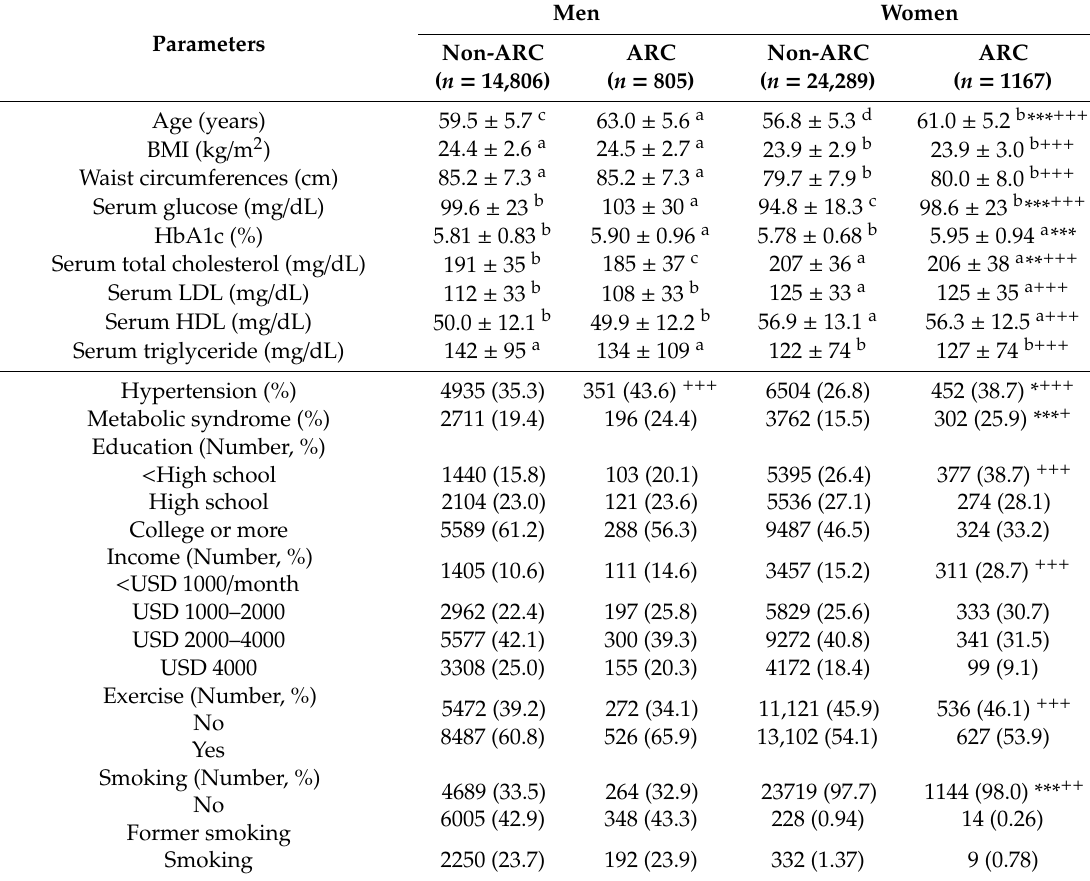
Table 1. Demographic, anthropometric, and biochemical parameters according to gender and age-related cataract (ARC)